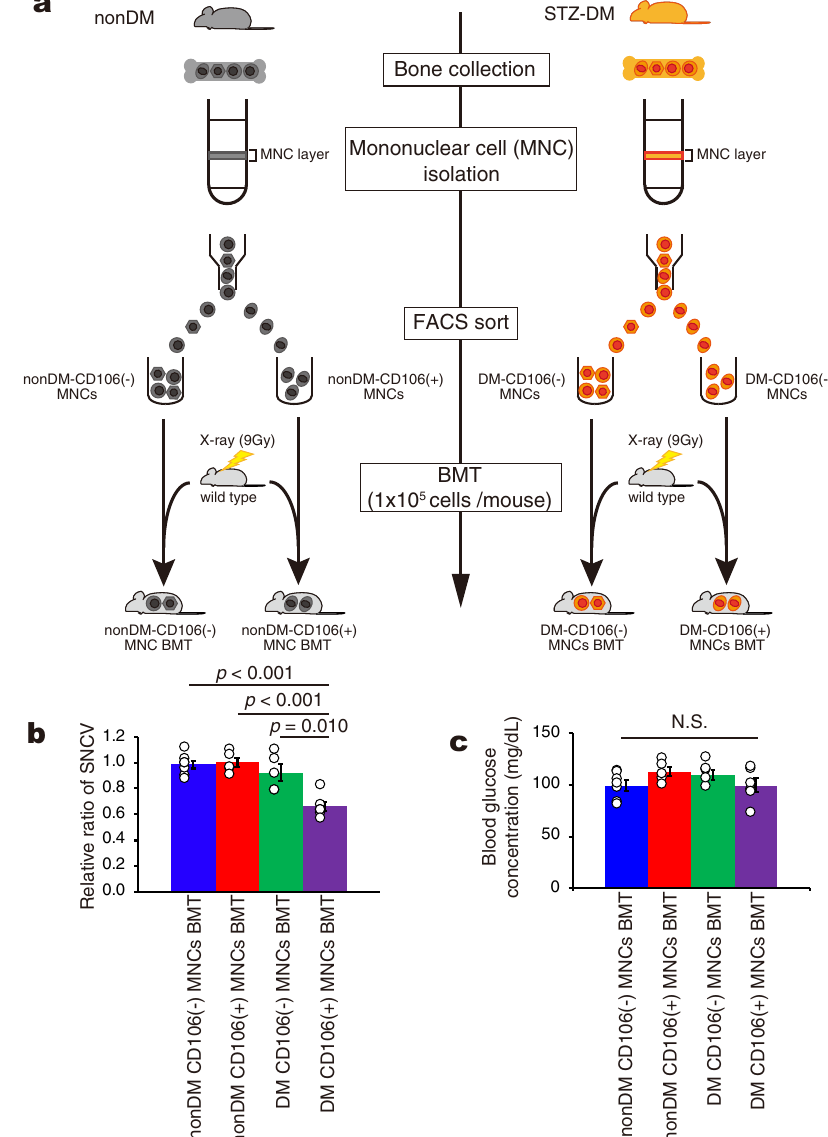
Fig. 6 Development of neuropathy in mice transplanted with CD106-positive mononuclear cells from diabetic mice. We isolated mononuclear cells using fi coll-paque PLUS from nondiabetic and diabetic total bone marrow. The isolated mononuclear cells were immunoreacted by PE-conjugated anti- CD106 antibody and sorted CD106-positive or -negative mononuclear cells by FACSAria fusion. Before anti-CD106 antibody staining, LIVE/DEAD Fixable Dead Cell Blue stain kit was used to deplete dead cells. Sorted cells (1 ×10 5 cells / mouse) were transplanted into 9 Gy lethally-irradiated normoglycemic mice. Four weeks after BMT, we measured blood glucose and sensory nerve conduction velocity. a A schematic experimental method for CD106-positive or -negative mononuclear cells transplantation model. b Relative ratio of SNCV of sciatic nerve in nonDM CD106( − ) MNCs BMT ( n = 7) compared to that in nonDM CD106( + ) MNCs BMT ( n = 5), DM CD106( − ) MNCs BMT ( n = 5) and DM CD106( + ) MNCs BMT ( n = 6). c Blood glucose concentration of nonDM CD106( − ) MNCs BMT ( n = 7), nonDM CD106( + ) MNCs BMT ( n = 5), DM CD106( − ) MNCs BMT ( n = 5) and DM CD106( + ) MNCs BMT ( n = 6). N.S means not signi fi cant. Data are indicated as means ±